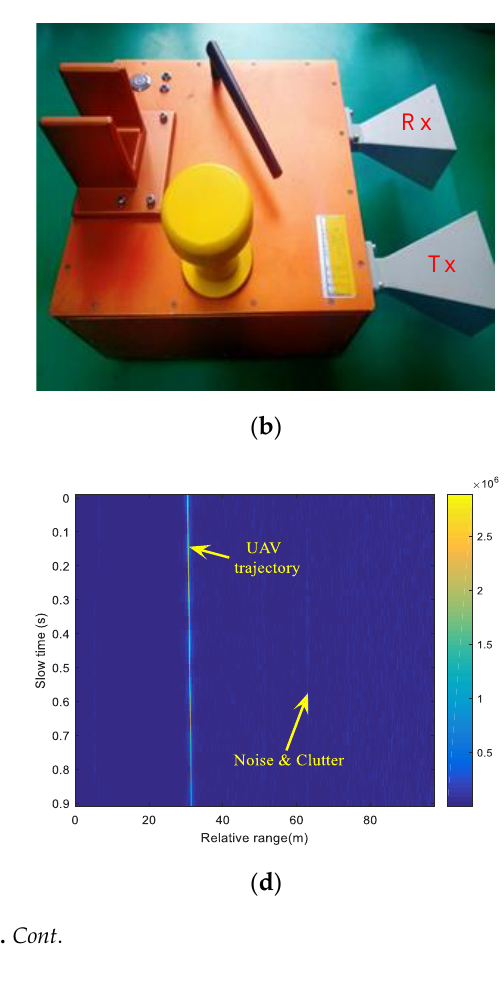
Table 4. Frequency-modulated continuous-wave (FMCW) radar parameters.